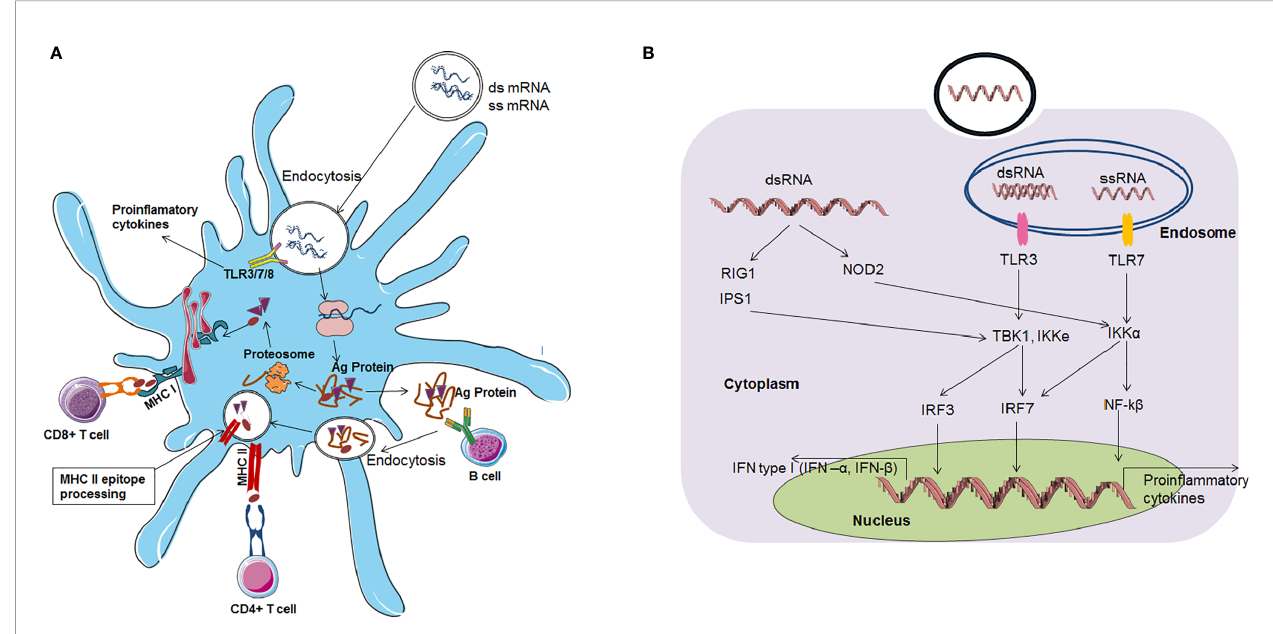
FIGURE 5 | mRNA vaccines based immune response (A) mRNA vaccine based adaptive immune response (B) mRNA vaccine based innate immune